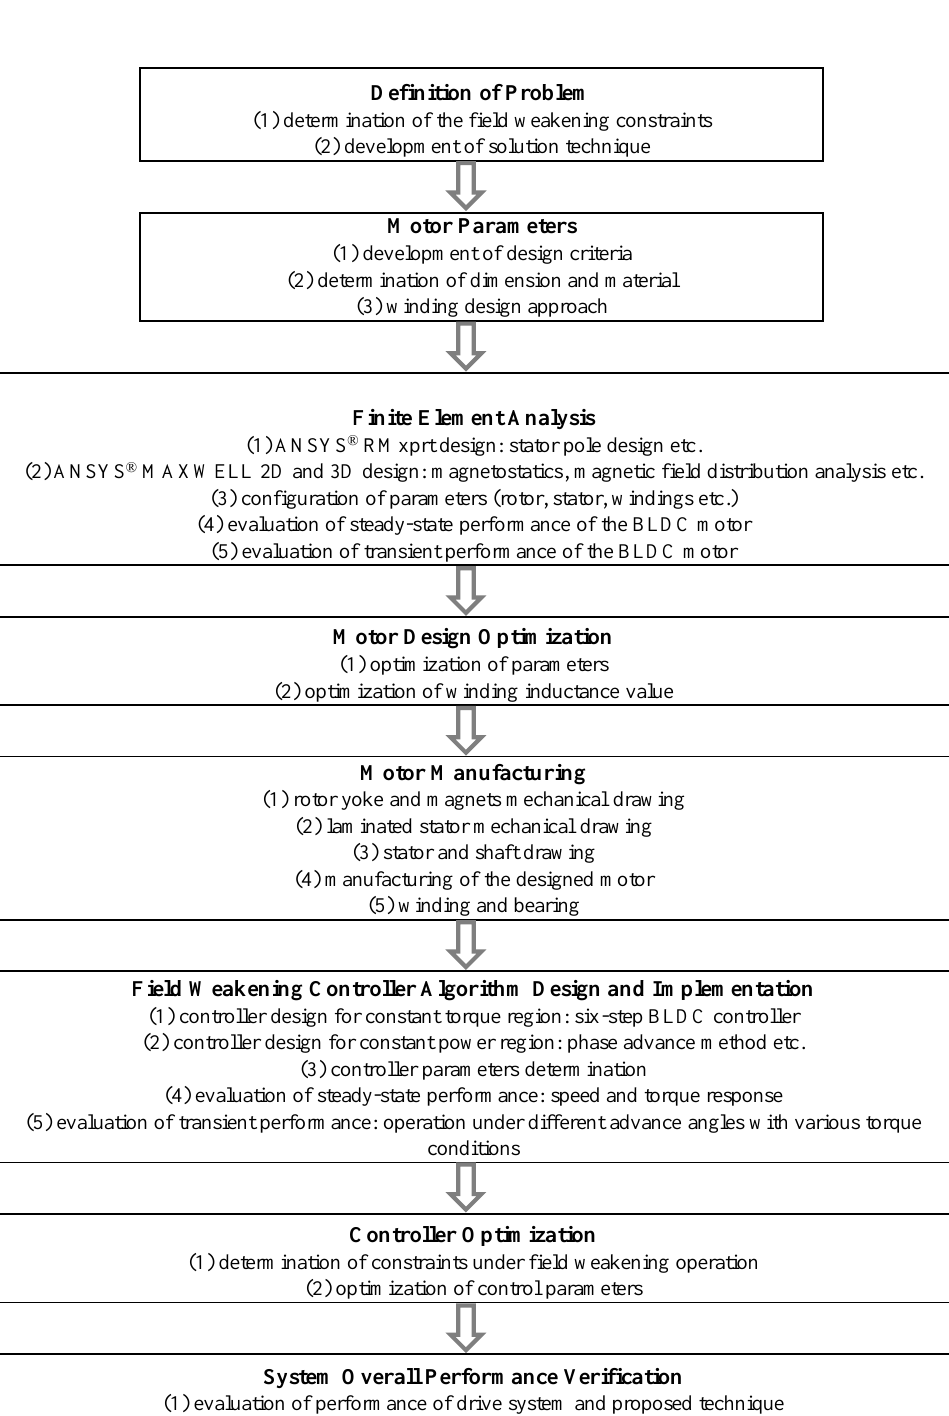
Figure A1. Design methodology